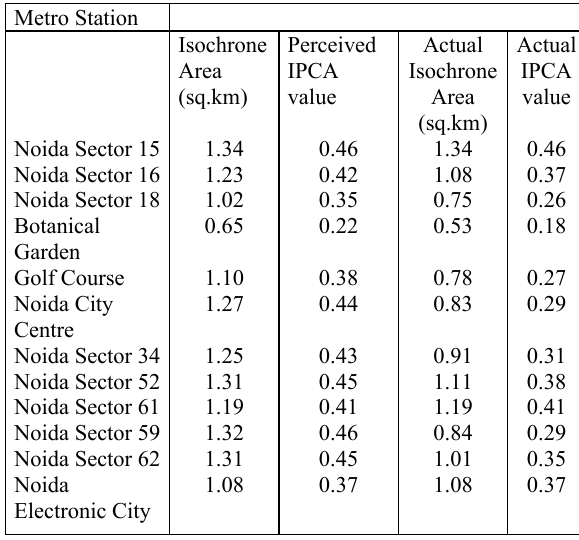
Table 7 . Perceived and Actual IPCA value.